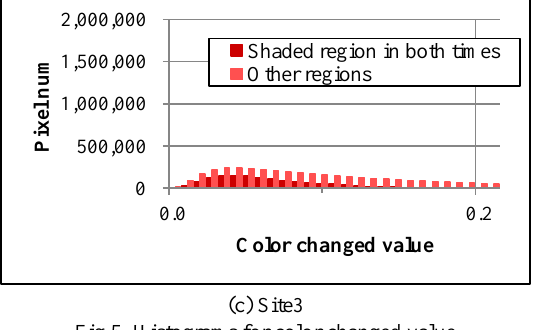
Fig.5. Histograms for color changed value (c) Shaded region in old time (d) Shaded region in new time Table 3. Thresholds for color changed value Fig.4. Result part of shaded region extraction in Site1 Table 2. Ratios of shaded region in both times and other regions Site1 Site2 Site3 Shaded region in both time 11.7% 12.3% 23.9% Other regions 88.3% 87.7% 76.1%